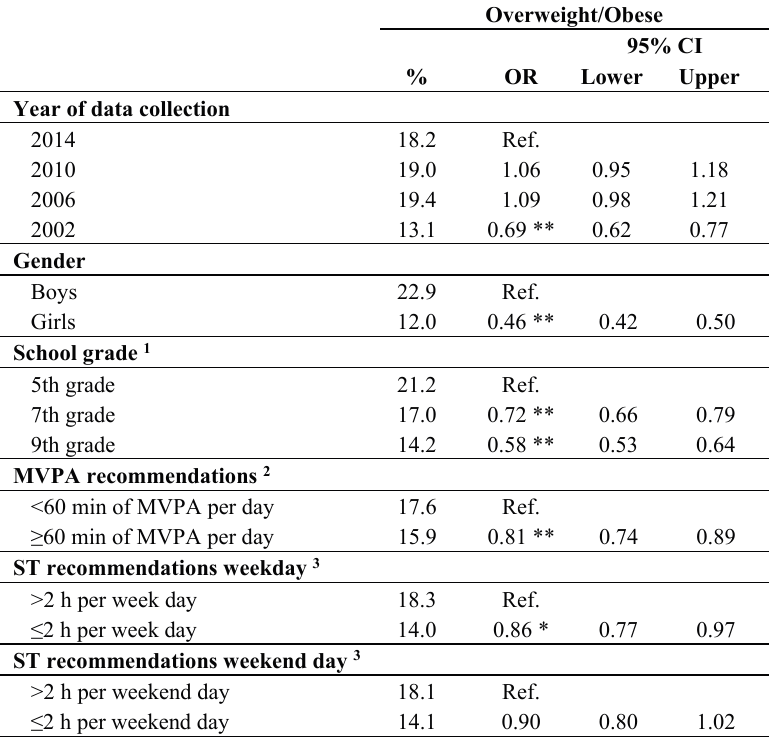
Table 3. Correlates of overweight/obesity in randomized sample of Czech adolescents.